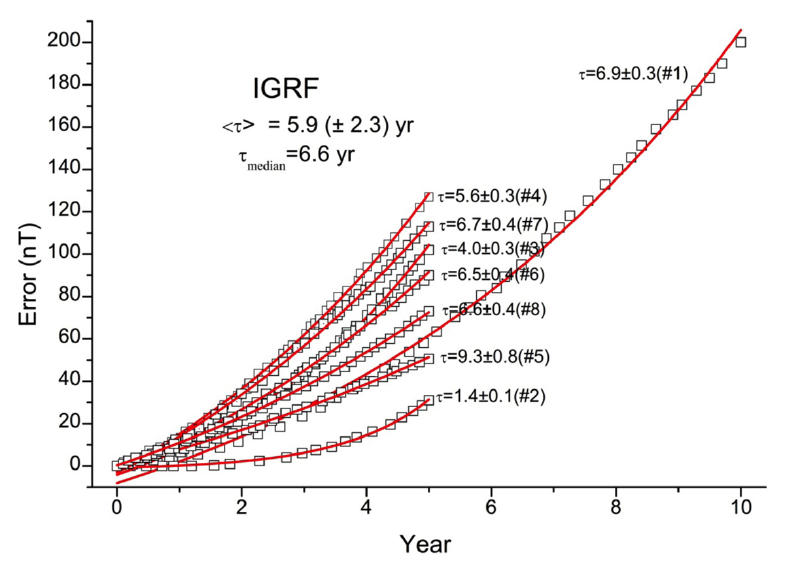
Figure 2. Error behavior between the predicted and observed global International Geomagnetic Reference Field (IGRF) models (from De Santis et al. [2011]). The exponential increase in time is a symptom of a chaotic geomagnetic